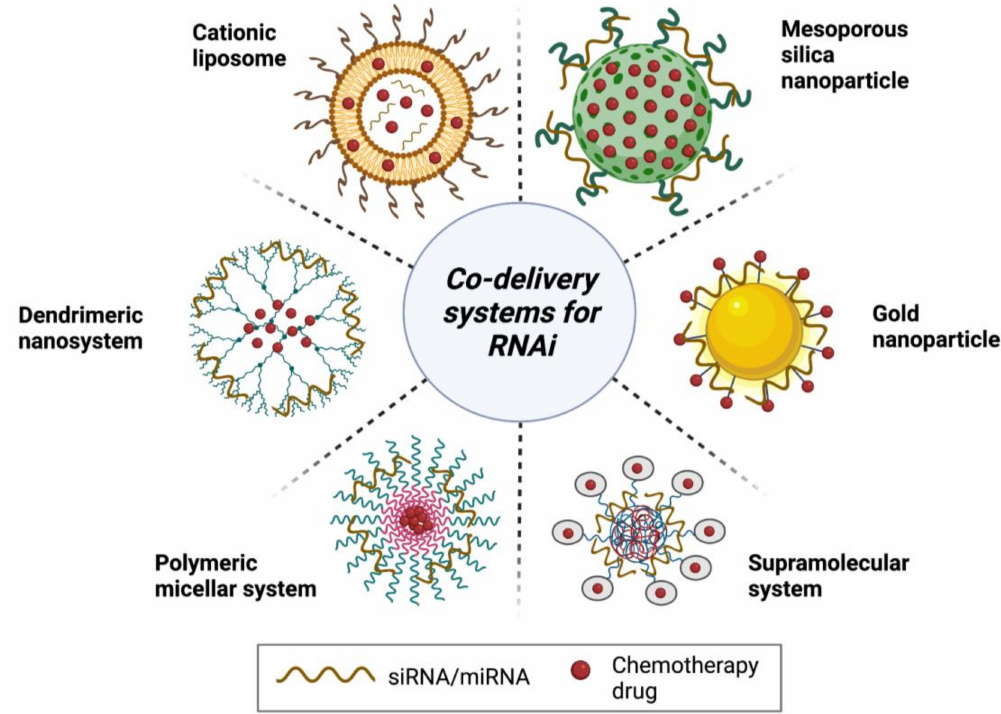
Figure 7. Selected co-delivery systems for combinatorial therapeutics [67]. Reproduced with permission from Wang, M. et al., Colloids Surf B Biointerfaces; published by Elsevier, 2017